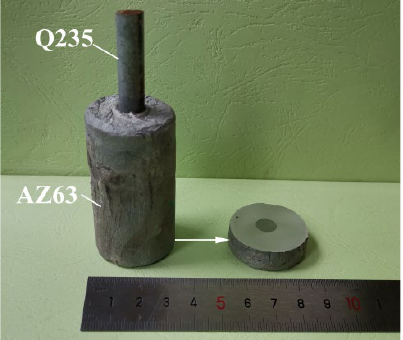
Figure 1. The sample obtained by composite casting.